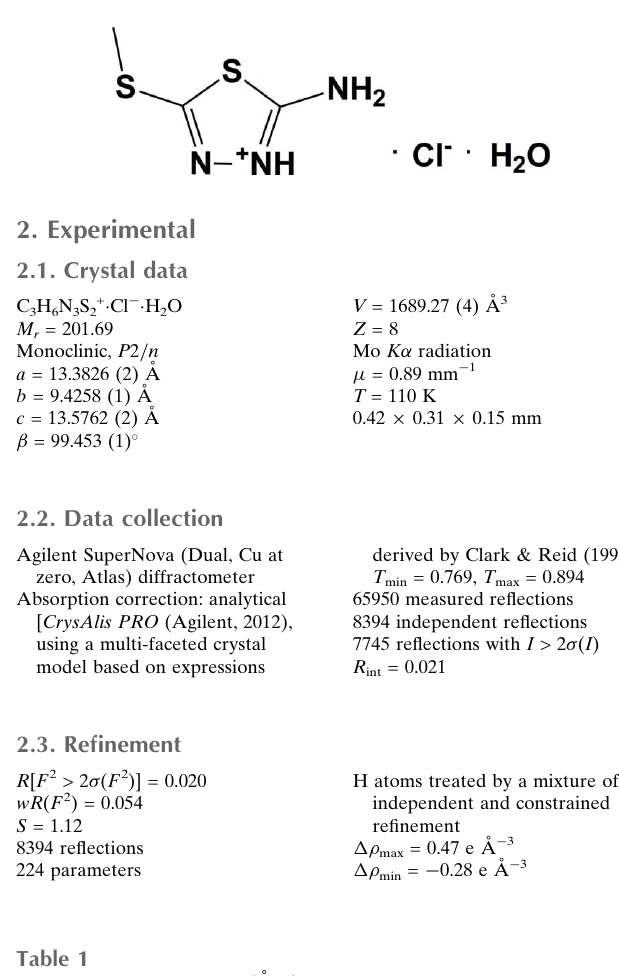
Hydrogen-bond geometry (A˚ , (cid:4)